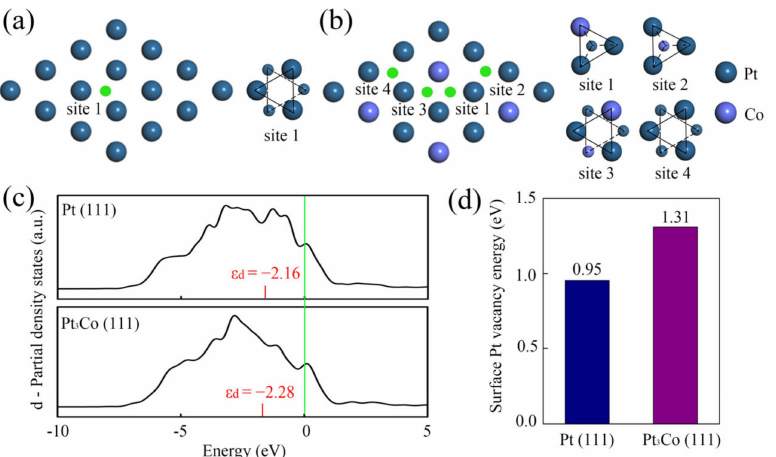
Figure 3. ( a ) DFT models and the adsorption sites of Pt (111). ( b ) Pt 3 Co (111) superlattice arrays. The smaller atom means the atom in the second layer of the catalyst, and the possible adsorption site of O atom is represented by the green dot. ( c ) The projected d-density of states (PDOS) of surface Pt atoms for Pt (111) and Pt 3 Co (111). ( d ) Pt vacancy formation energies for Pt (111) and Pt 3 Co (111)